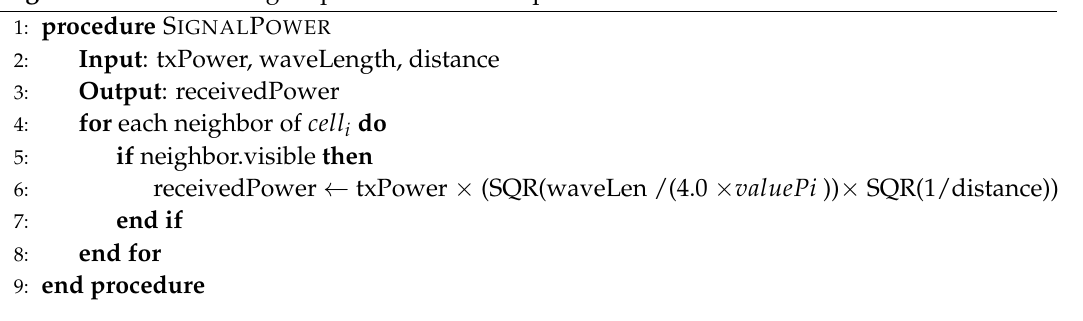
Algorithm 2 Received signal power in the Free Space Path Loss